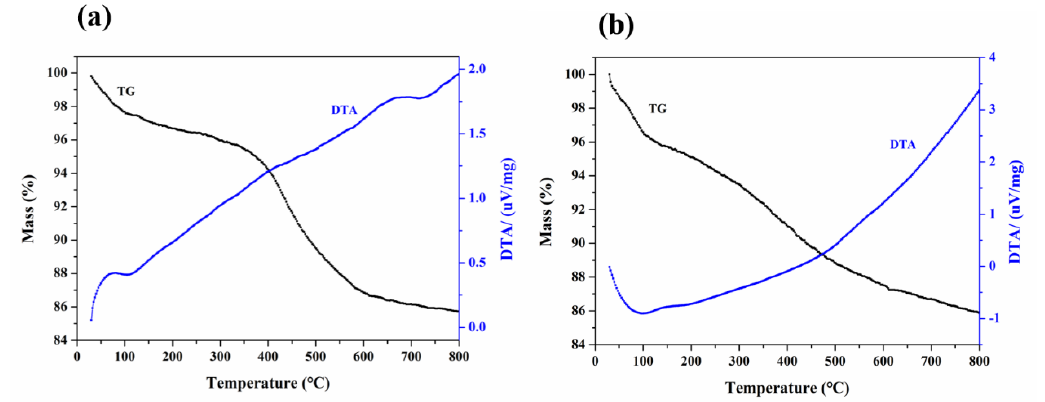
Figure 2. Thermogravimetric (TG) / di ff erential thermal analysis (DTA) of the ( a ) SiO 2 and ( b ) rGO / SiO 2 samples.